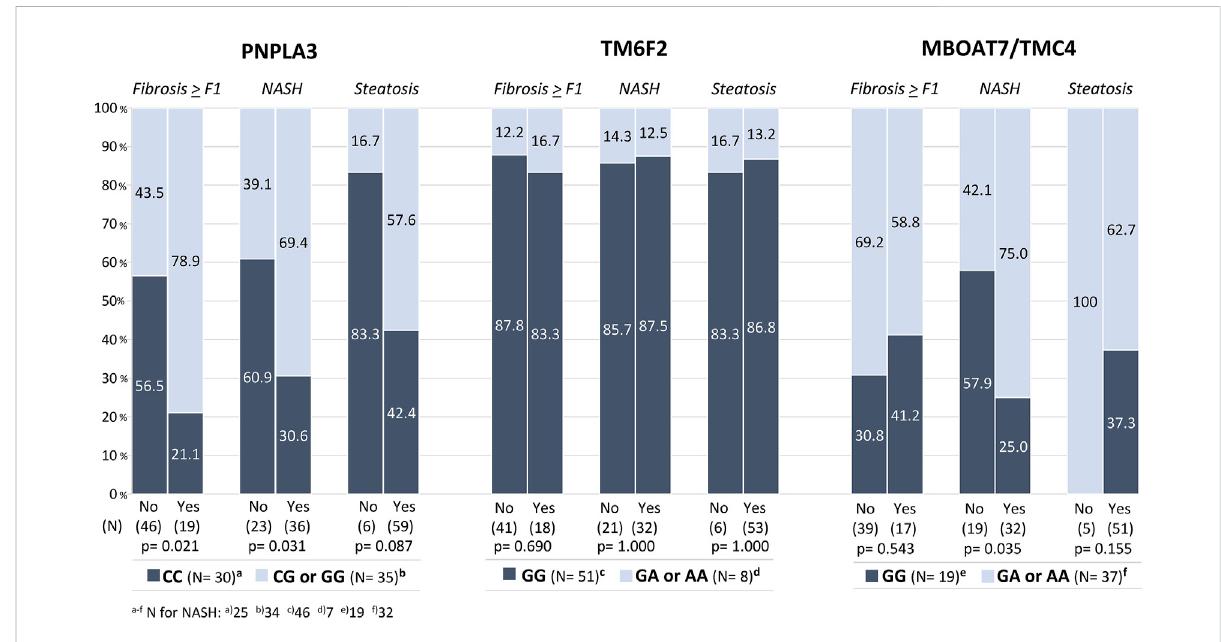
FIGURE 2 (A – C) : Distribution of allele variants in each histopathological category.